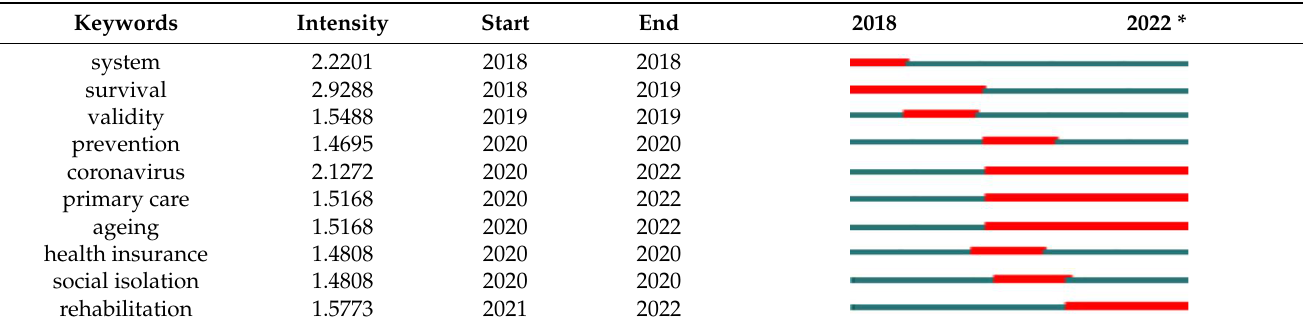
Table 6. Burst keyword strength and timing of FCMNCE research in 2018–2022.